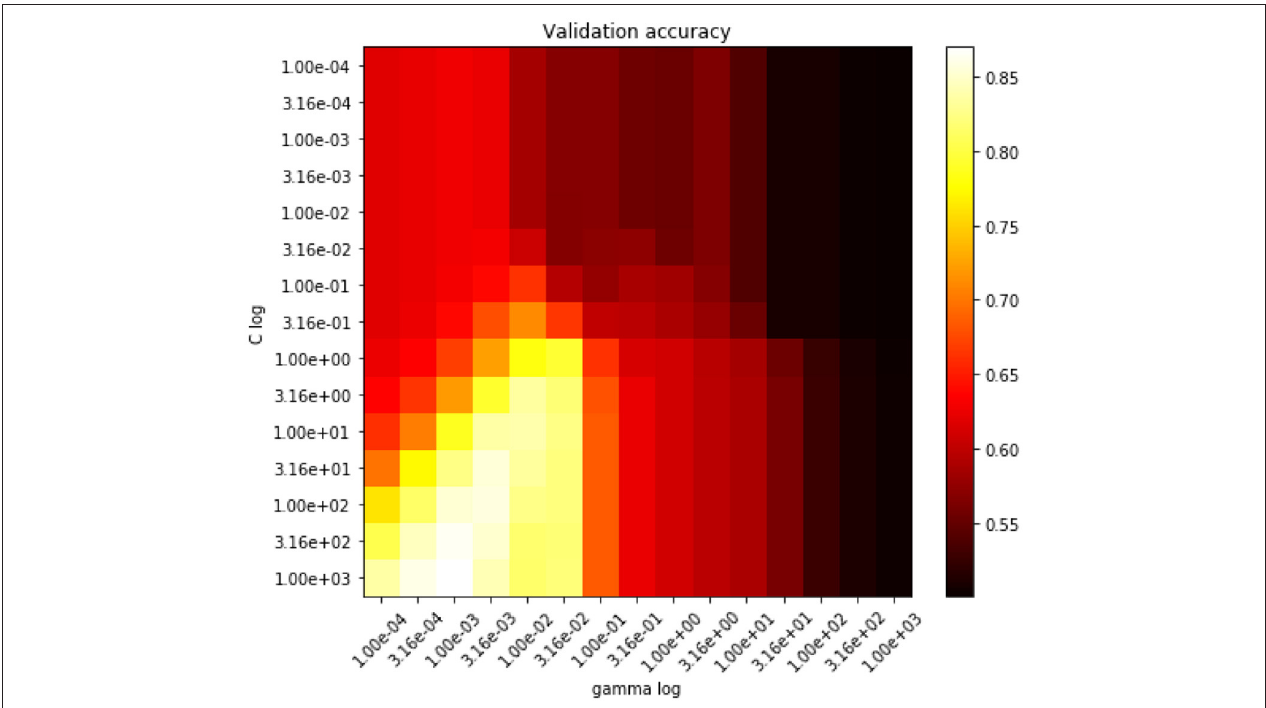
FIGURE 8 | Accuracy hyperparameter grid search for the SVM